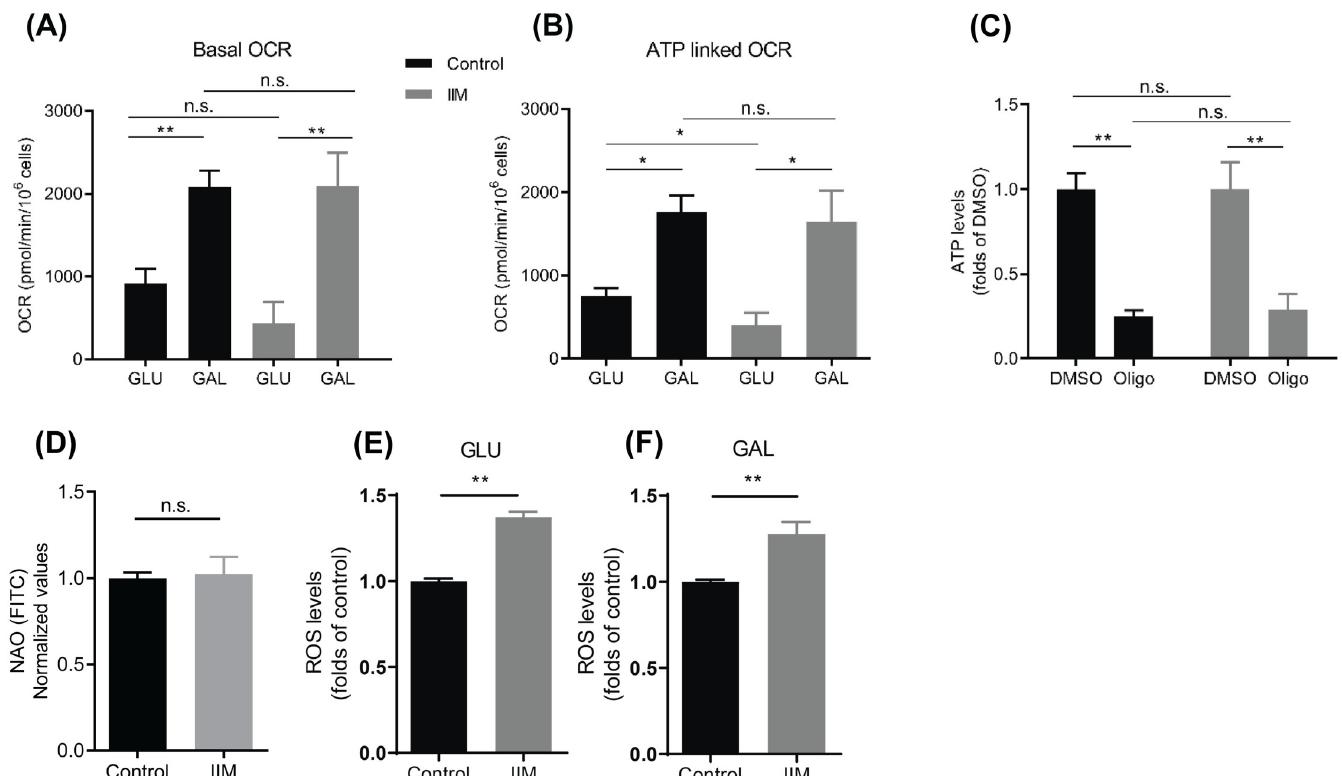
Fig 2. A metabolic challenge reveals functional mitochondria in IIM-derived cells and a mitochondrial-dependent sensitivity to ROS-mediated cell death. Control and IIM-derived cells were grown for seven days either in glucose (GLU) or galactose (GAL) media. Oxygen consumption rate (OCR) show that both Control and IIM- derived cells were able to; (A) increase basal and (B) ATP linked OCR when cultured in GAL. (C) Total ATP levels in control and IIM-derived cells showed negligible differences in basal conditions (DMSO) and a significant drop when treated with the ATP synthase inhibitor oligomycin (Oligo) (1 μ M) for 2 h. (D) Mitochondrial mass was determined using the cardiolipin fluorescence label NAO. No differences were found between Control and IIM-derived cells after seven days in GAL media (E and F) Reactive oxygen species (ROS) levels were measured using DHE. In both growing media (GLU and GAL) IIM derived cells showed increased ROS levels when compared with control